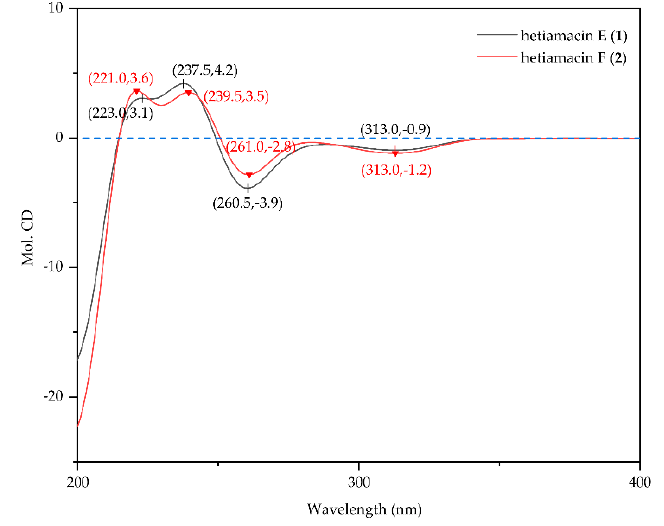
Figure 5. CD spectra of hetiamacin E ( 1 ) and hetiamacin F ( 2 ).